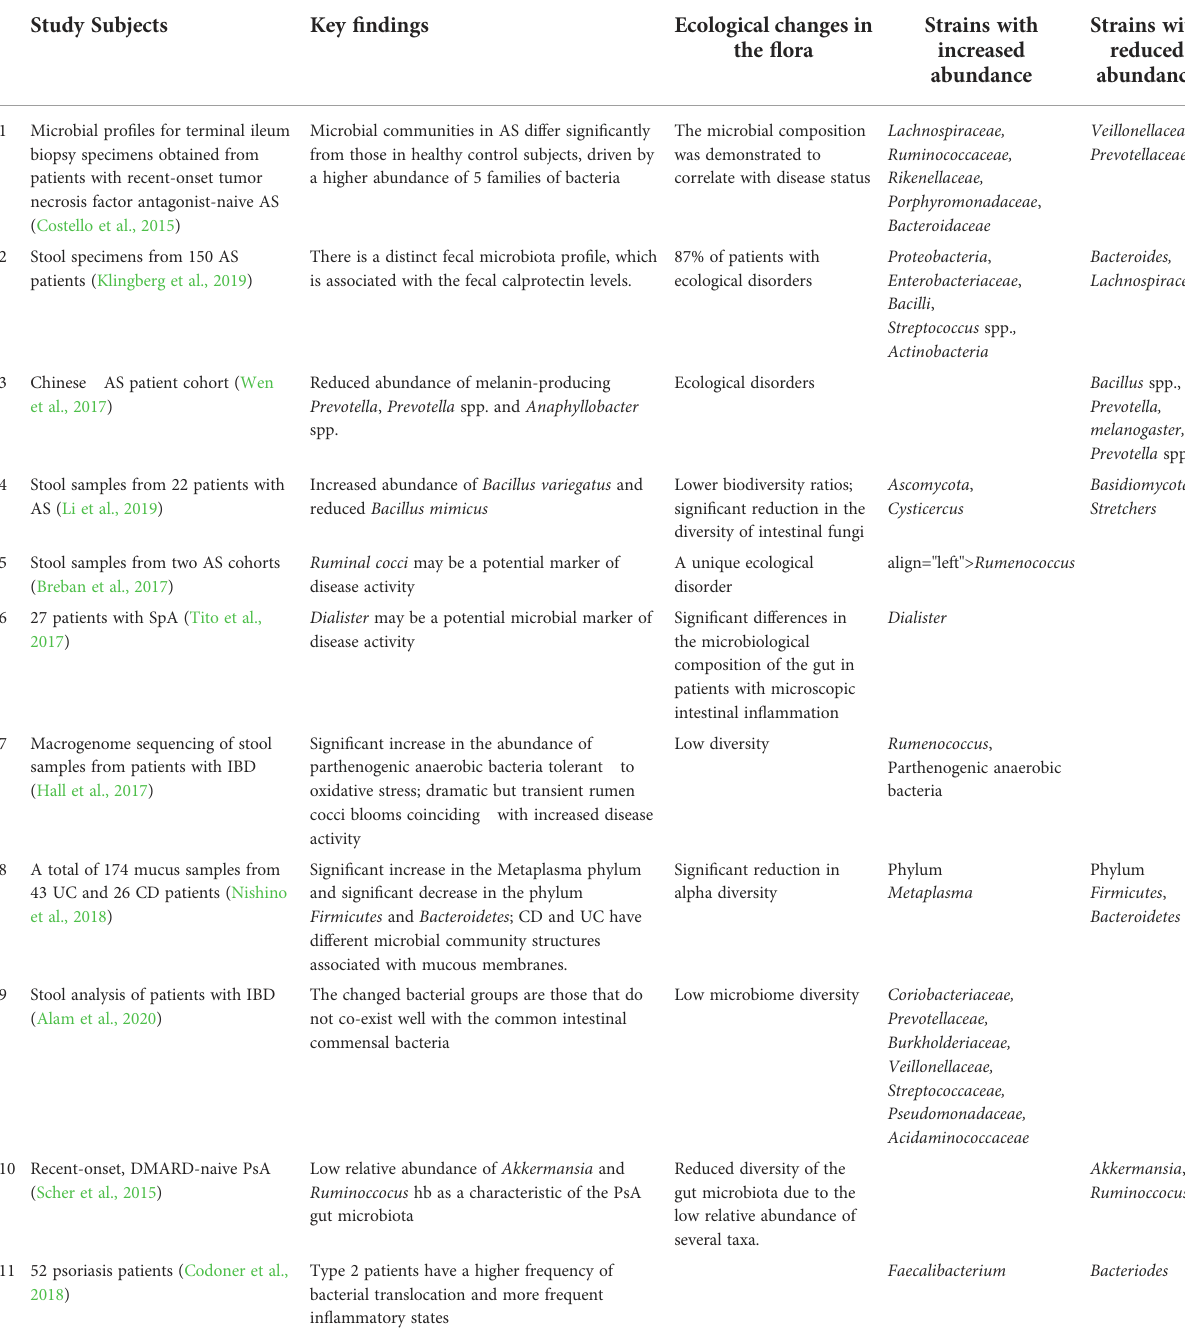
TABLE 1 Recent fi ndings on changes in the SpA gut